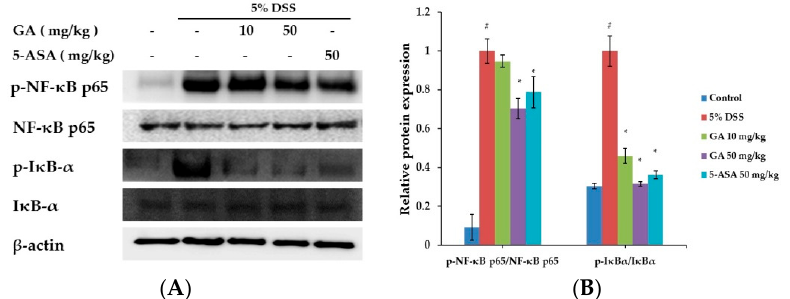
Figure 4. Effects of GA on transcription factors in DSS-induced UC. ( A ) Phosphorylation of I κ B α and phosphorylation of NF- κ B were assayed by Western blot; ( B ) Relative ratio of phospho-I κ B α and NF- κ B